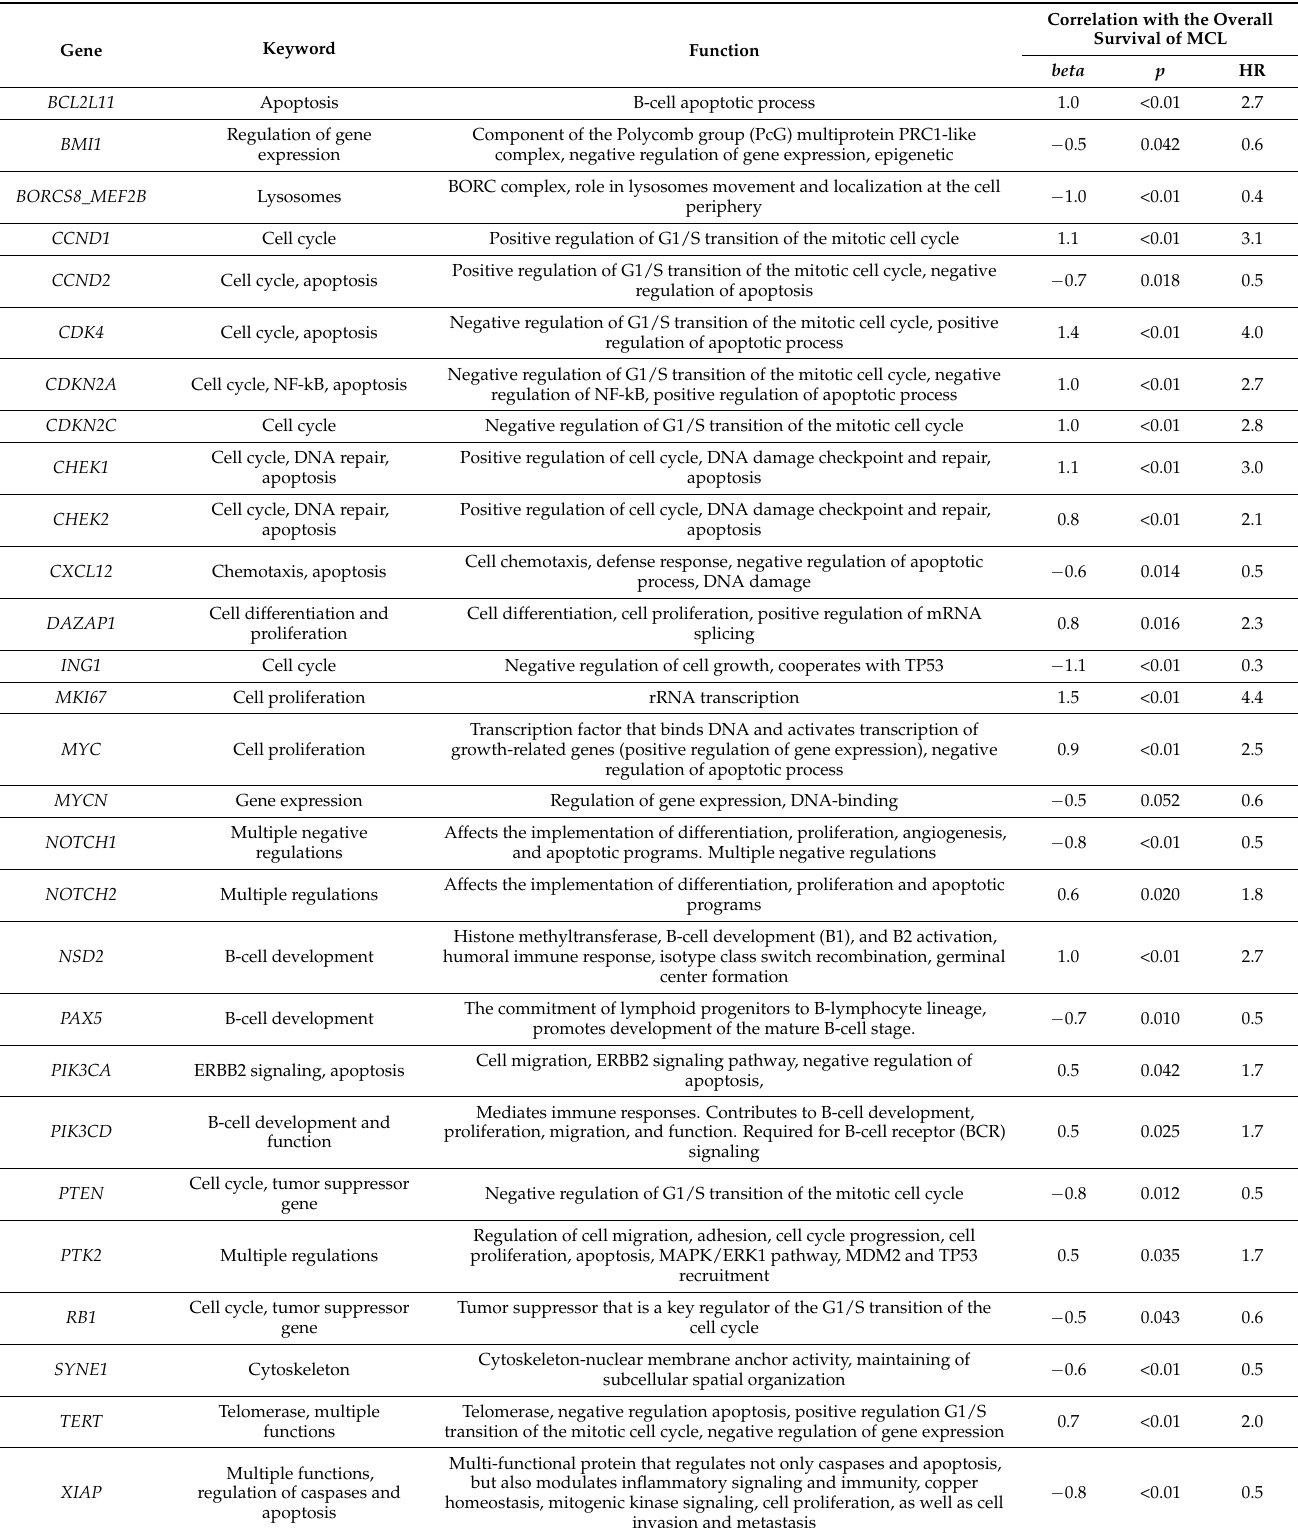
Table 2. Pathogenic genes of mantle cell lymphoma (GSE93291 series) (Method